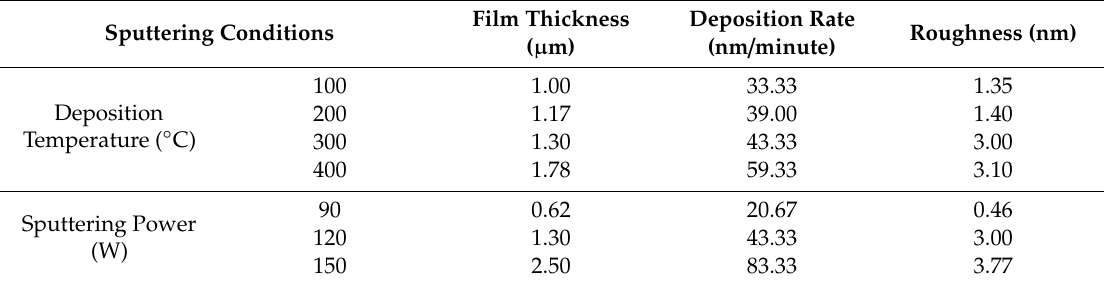
Table 2. The influence of RF power and substrate temperature conditions on the structural